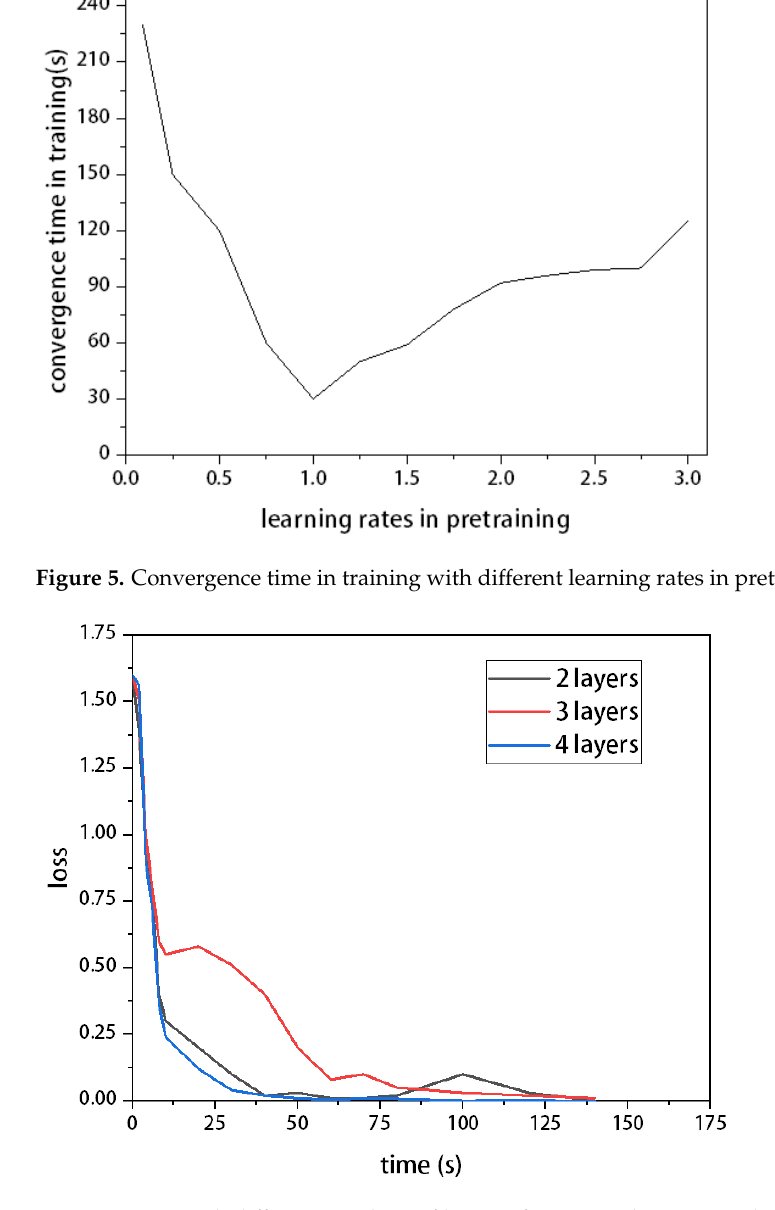
Figure 6. Loss with different numbers of layers of LSTM in the training dataset.